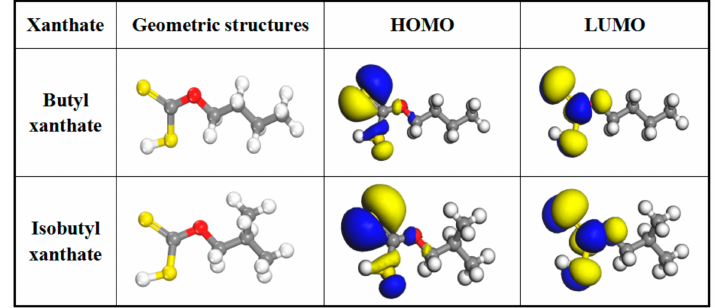
Figure 10. Optimized molecular structures and frontier molecular orbital of butyl xanthate and isobutyl xanthate (Color codes: red = O, yellow = S, white = H and gray = C).